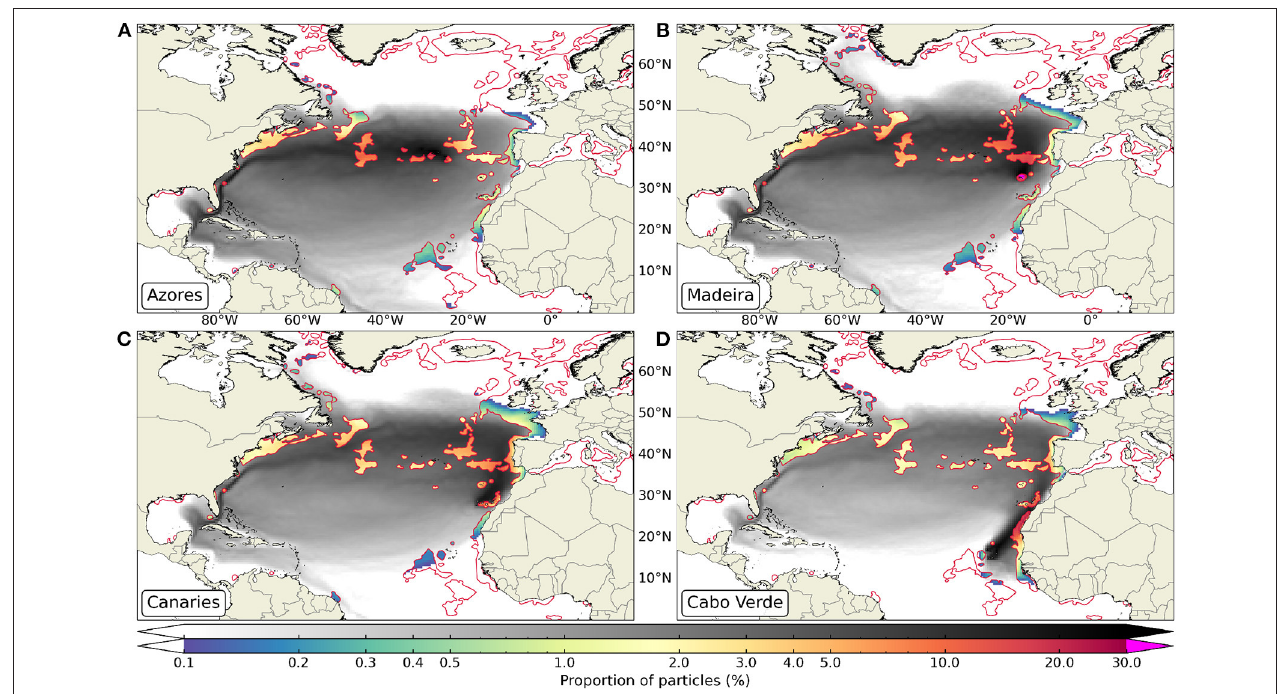
FIGURE 7 | Proportion of B surface particles released in the Azores (A) , Madeira (B) , Canaries (C) , and Cabo Verde (D) , detected in 0.5 ◦ grid cells and clipped by the areas with > 150 h of fishing effort (per 0.2 ◦ grid cell) reported in the Global Fishing Watch dataset ( Kroodsma et al., 2018). Only fishing areas with > 5,000 km 2 are represented by the red contours. Color maps are in logarithmic scale, in which cells with < 0.1% are